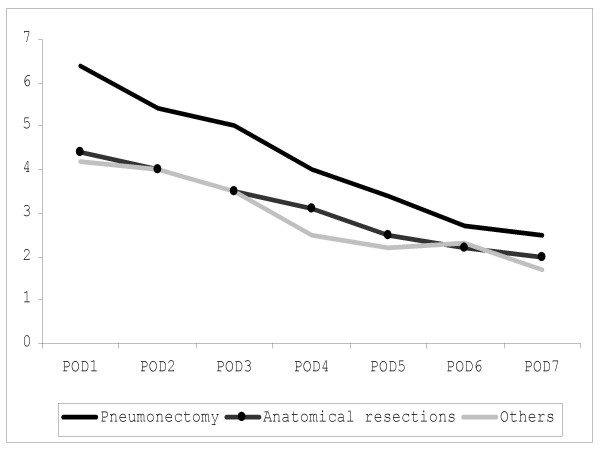
In uncomplicated patients, the mean FLAM score is moderately higher after pneumonectomy than after lobectomy, confirming the clinical impression that pneumonectomy patients are more delicate than lobectomy patients during the first 2–3 postoperative days.